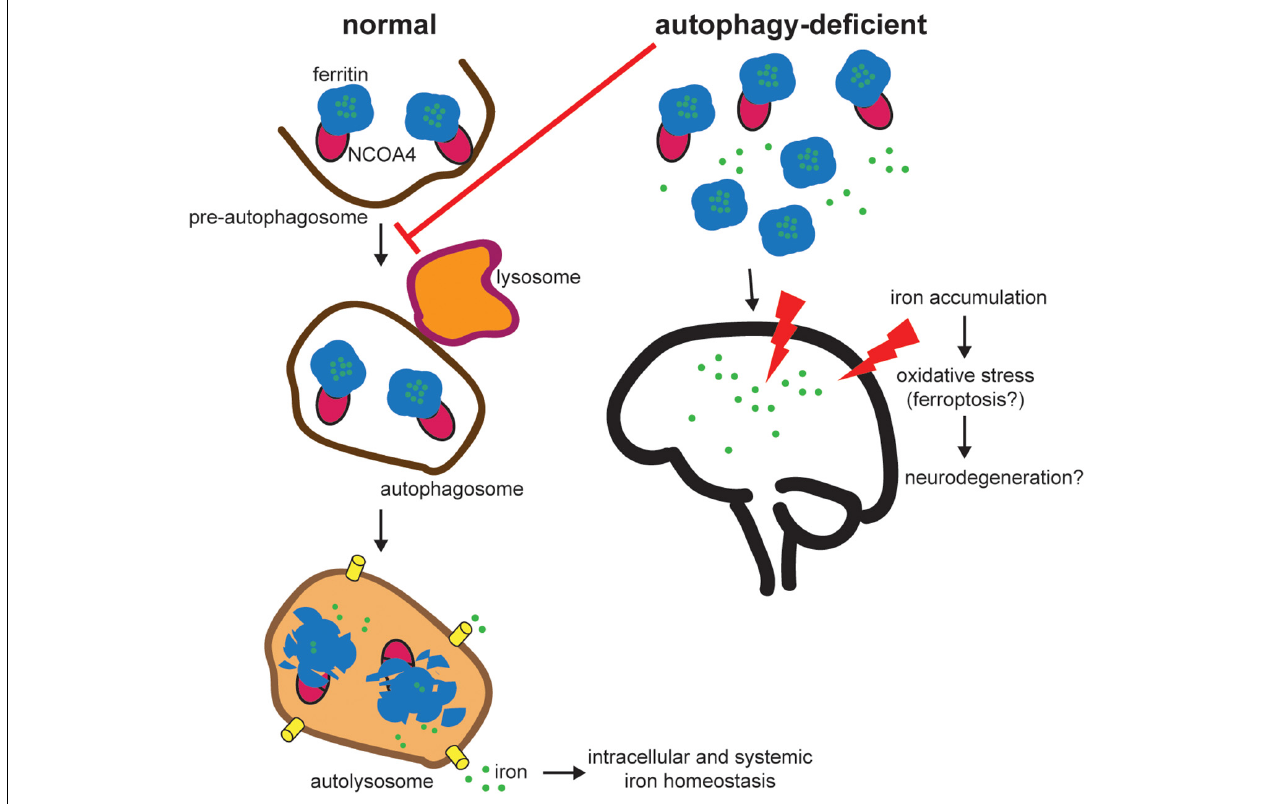
FIGURE 1 | NCOA4-mediated ferritinophagy modulates intracellular and systemic iron homeostasis. NCOA4 binds iron-laden ferritin and delivers it to a pre-autophagosome structure. Upon autophagosome-lysosome fusion, ferritin is degraded, iron is released into the lysosome and exported to the cytosol for use in multiple iron-dependent physiological processes (e.g., mitochondrial heme synthesis). Under pathologic autophagy-deficient conditions, one model predicts that NCOA4 is unable to target ferritin for lysosome degradation leading to accumulation of ferritin and an iron overload phenotype (based on in vivo studies of NCOA4 knockout). Excess free iron is associated with reactive oxygen species generation and oxidative stress and may contribute to neurodegeneration. Further experimentation is necessary to link specific defects in the NCOA4-mediated ferritinophagy pathway to